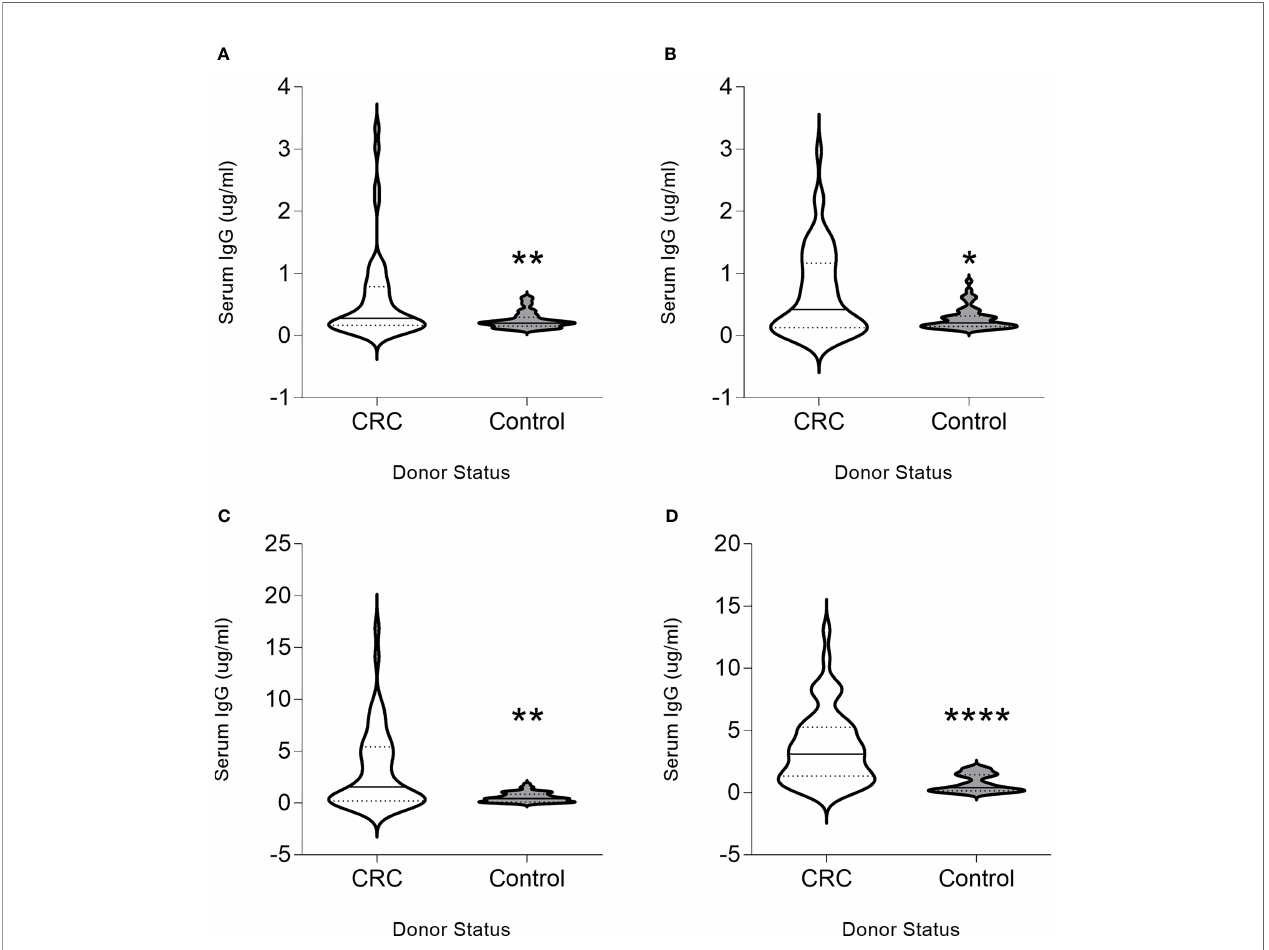
FIGURE 1 | CDC25B, COX2, FASCIN1 and RCAS1 are colon cancer antigens. Serum IgG (µg/ml) from donors with colorectal cancer (CRC) or volunteer controls (control) for (A) CDC25B, (B) COX2, (C) FASCIN1 and (D) RCAS1 presented as violin plots, solid line at median and dotted lines at quartiles. *p < 0.05, **p < 0.01, ****p <